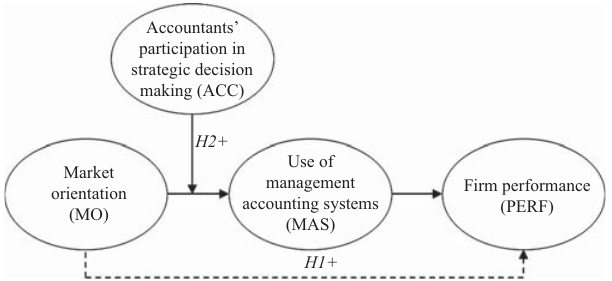
Figure 1. The proposed